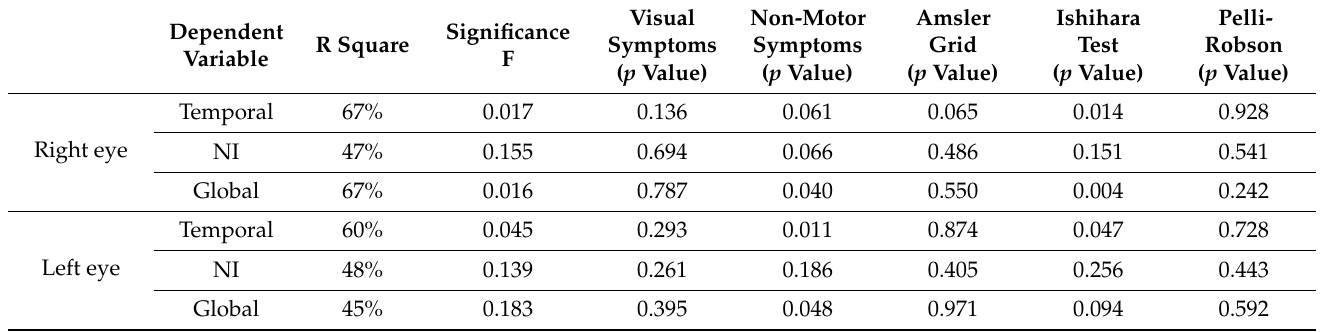
Table 4. Regression summary.